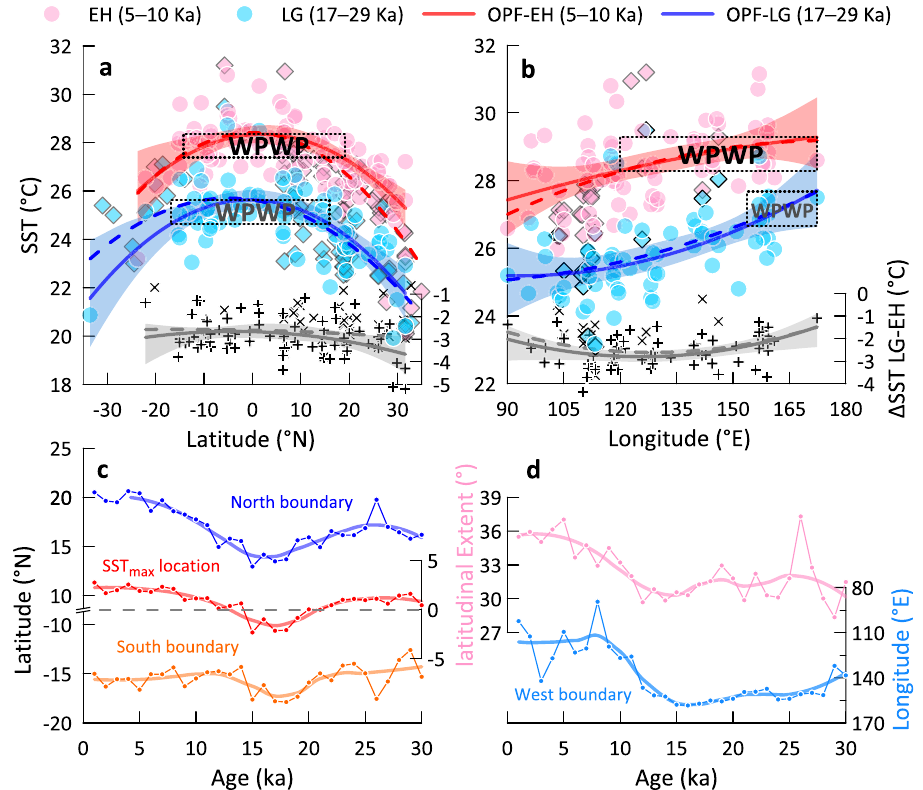
Fig. 3 | Variations in the spatial extent of the western Paci fi c warm pool since 30ka. a Comparisons of meridional and b zonal variations in the extent of the western Paci fi c warm pool (range of top 1°C) in the last glacial (blue) and early Holocene (red), based on sea surface temperature distributions. Trend lines are orthogonal polynomial fi ttings (OPF) based on Mg/Ca (solid) and mixed tempera- ture proxies (Mg/Ca and U k ’ 37 , dashed), with 90% con fi dence (shadows). Gray lines are discrepancies between the last glacial and early Holocene. Mg/Ca results are shownbycirclesandplussigns,whileU k ’ 37 resultsarerepresentedbydiamondsand crosses.ThespatialextentofthewesternPaci fi cwarmpoolmarkedbydottedboxes is based on sea surface temperature data from Mg/Ca, which are more uniformly